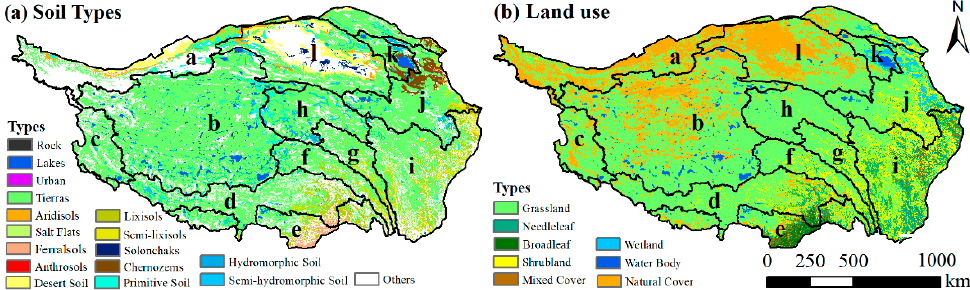
Figure 2. Spatial distributions of soil and land use types over the Tibetan Plateau.